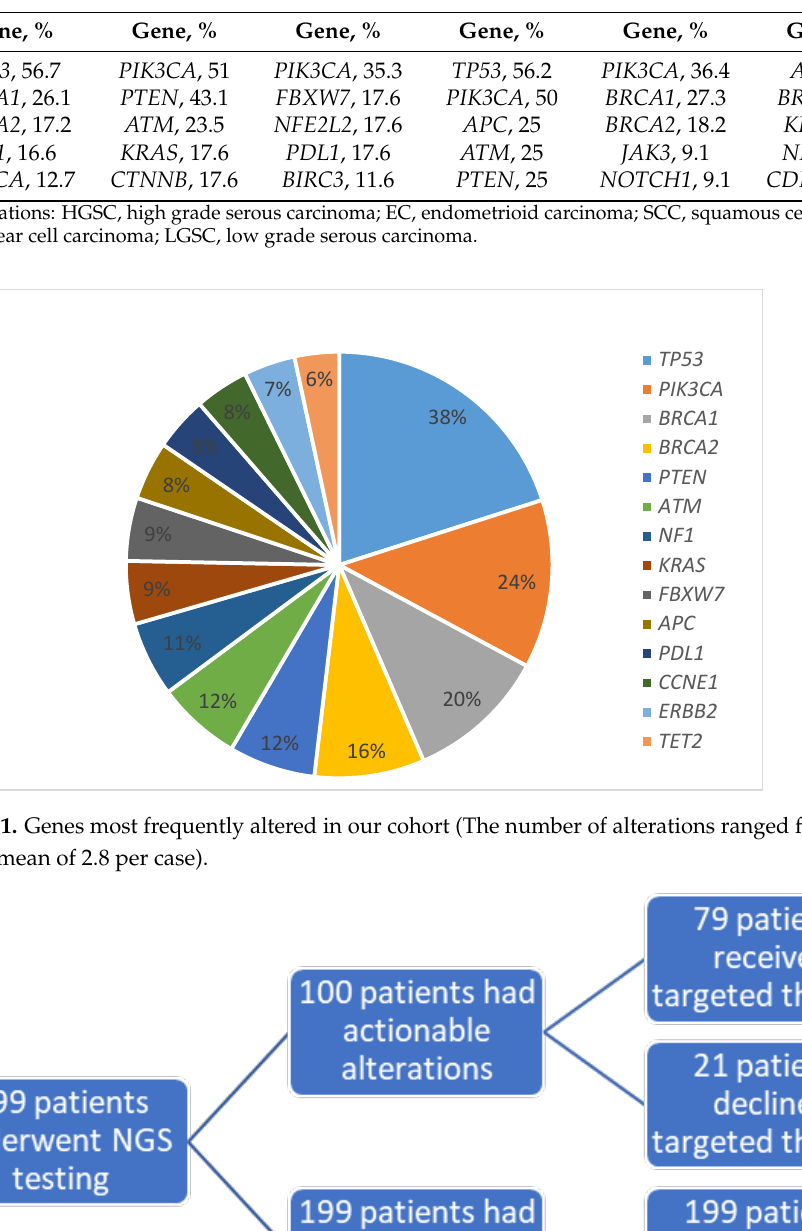
Figure 3. Overall survival based on next-generation sequencing (NGS) test result. p = 0.002 by log- rank test. 4. Discussion In this era of modern technology, genetic testing has progressed from single-gene based assays to much more complex next-generation sequencing (NGS) based assays. NGS is a rapidly evolving technology that has facilitated fast- and high-throughput